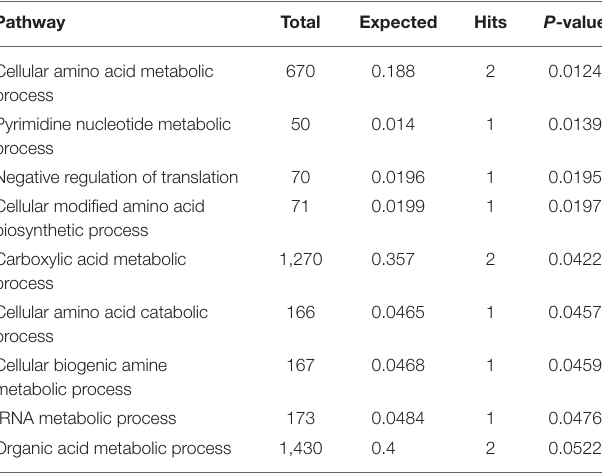
TABLE 3 | Pathways enriched by proteins and metabolites in subnetwork 3 of the protein–metabolite interaction network based on the GO:BP database. Pathway